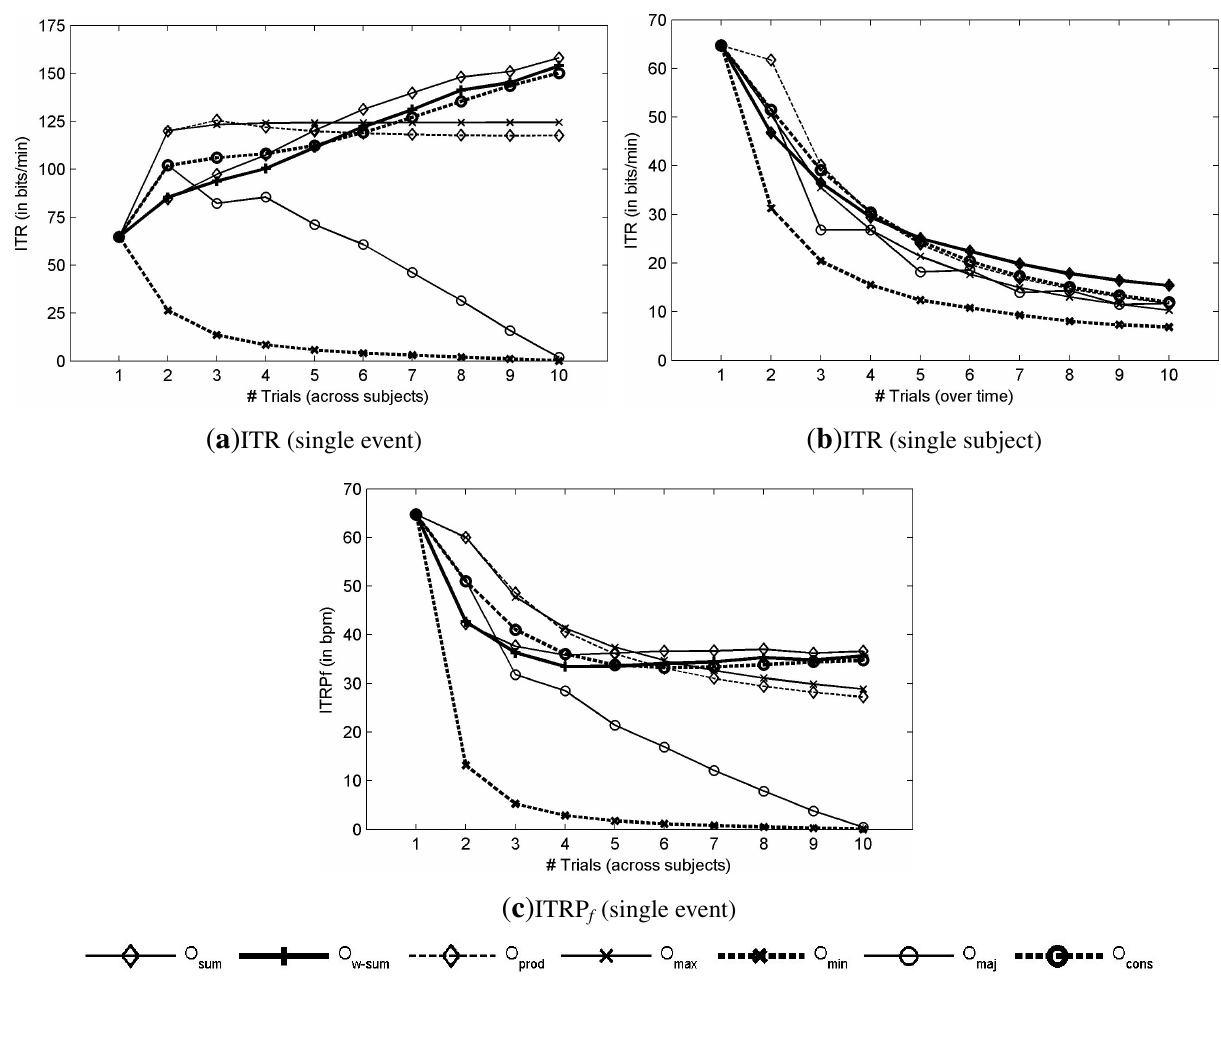
Figure 4. Detection results based on the ITR and ITRP of the number of subjects and the number of trials, respectively. ( c ) theoretical ITRP function of the number of subjects and the number of trials,